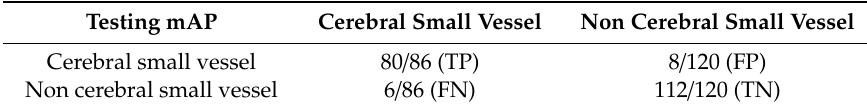
Table 3. Training mAP of YOLO1 model. Table 4. Testing mAP of YOLO1